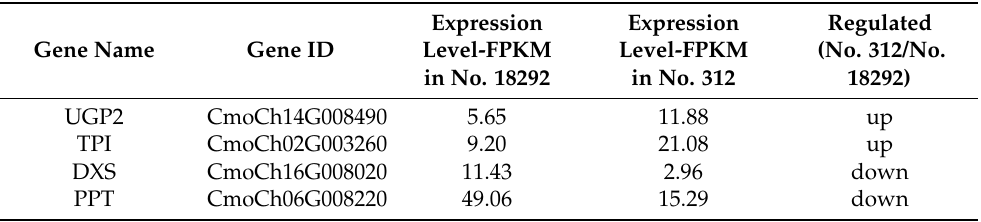
Table 4. The expression levels from RNA-seq of four genes related to 2-acetyl-1-pyrroline in the leaves of pumpkin sample NO.312 with ‘taro-like’ aroma and sample NO.18292 without ‘taro-like’ aroma.